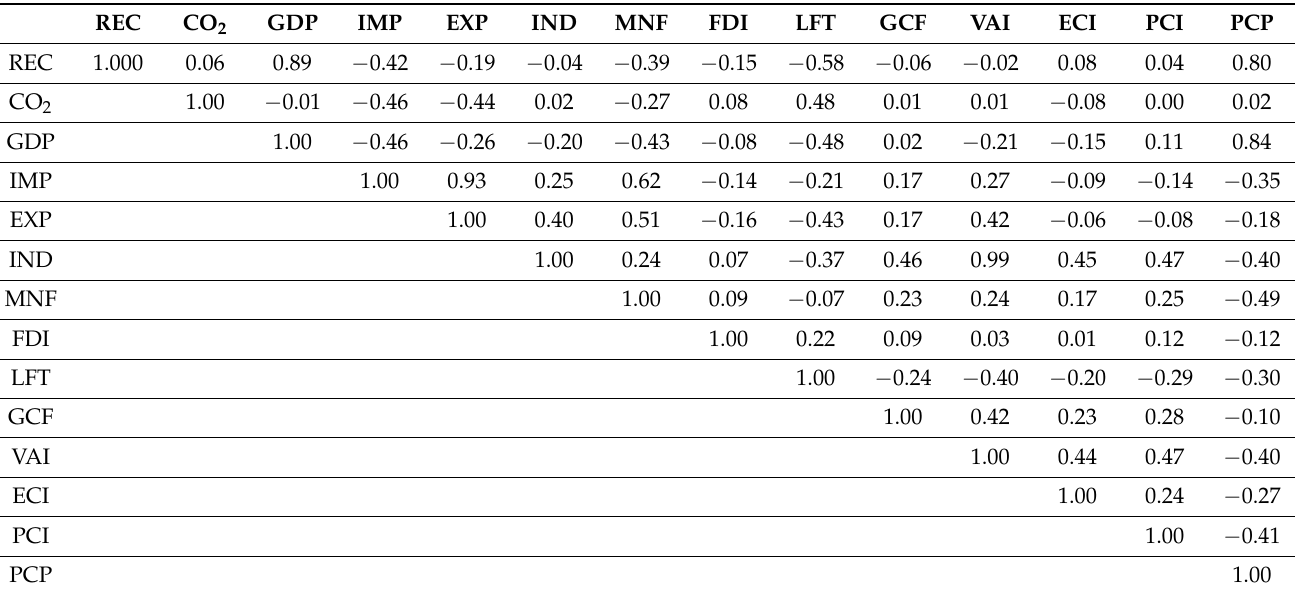
Table 4. Correlation matrix.